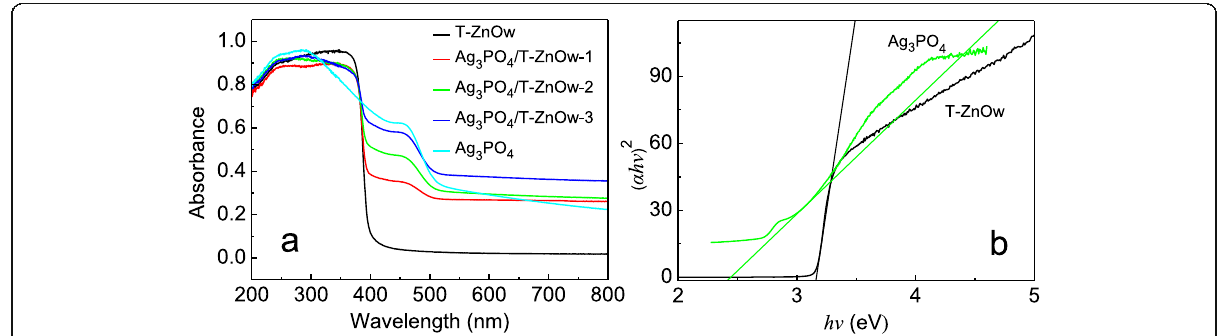
Fig. 4 a UV-Vis DRS of T-ZnOw, Ag 3 PO 4 /T-ZnOw-1, Ag 3 PO 4 /T-ZnOw-2, Ag 3 PO 4 /T-ZnOw-3, and Ag 3 PO 4 . b Plots of ( α hv ) 2 versus energy ( hv